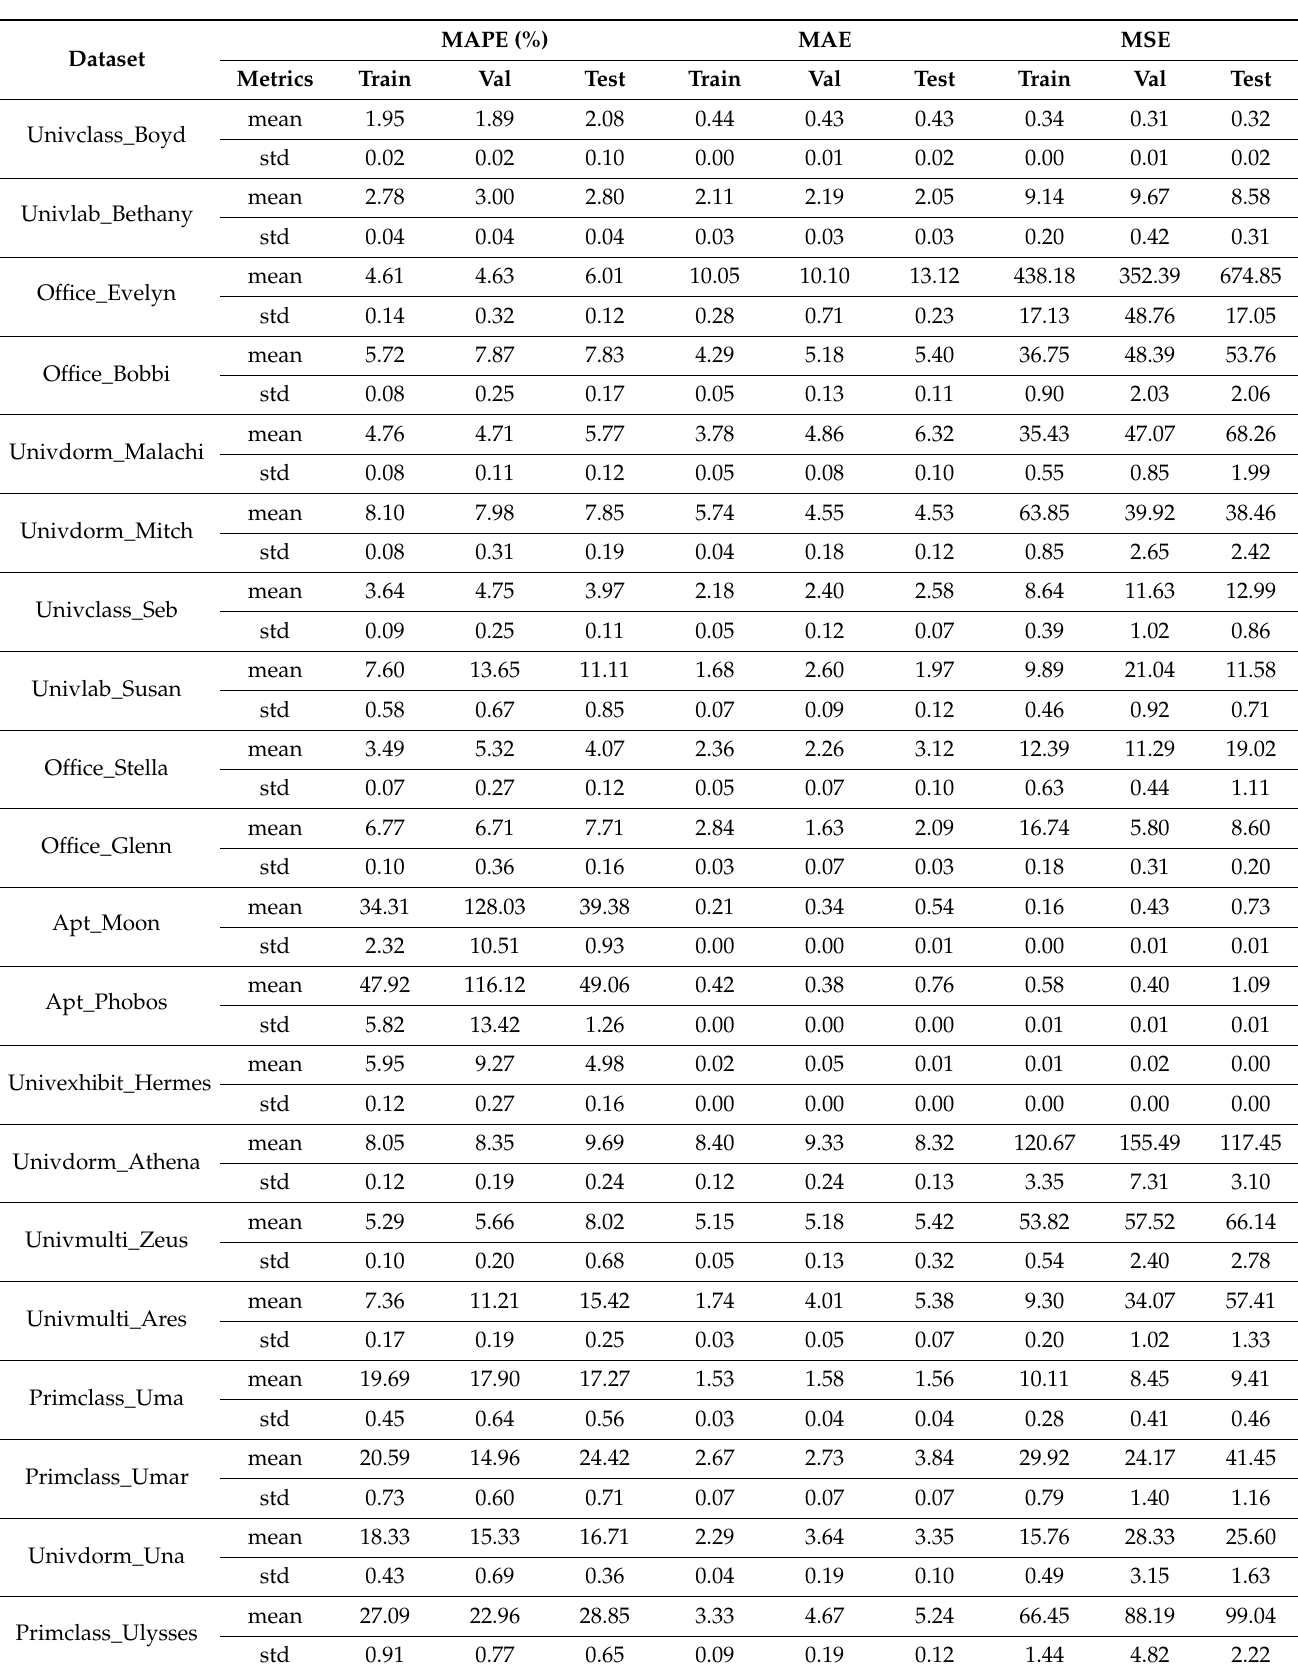
Table 7. The MAPE, MSE, and MAE of forecasting using LSTM without